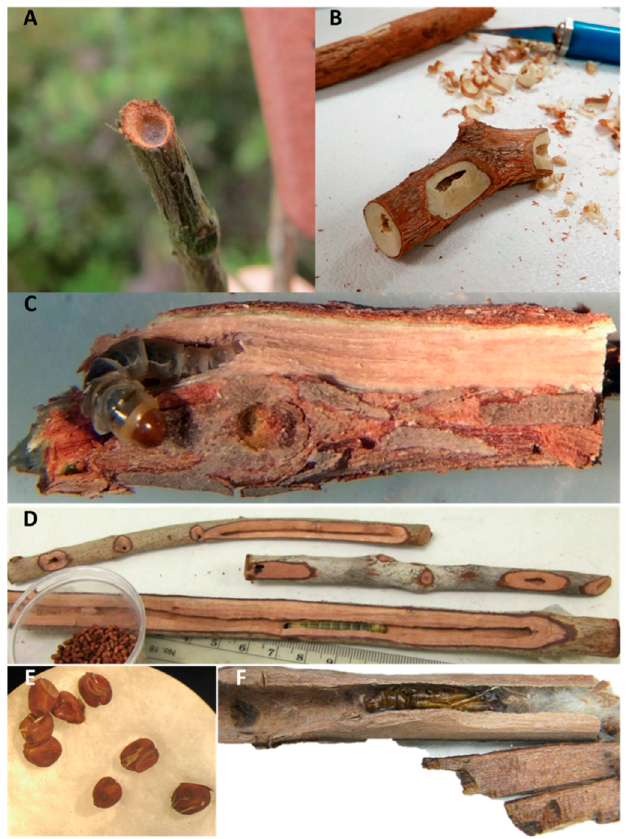
Figure 3. ( A ) Webbed Casmara subagronoma larval bore observed in the field in Hong Kong (photo J.R.